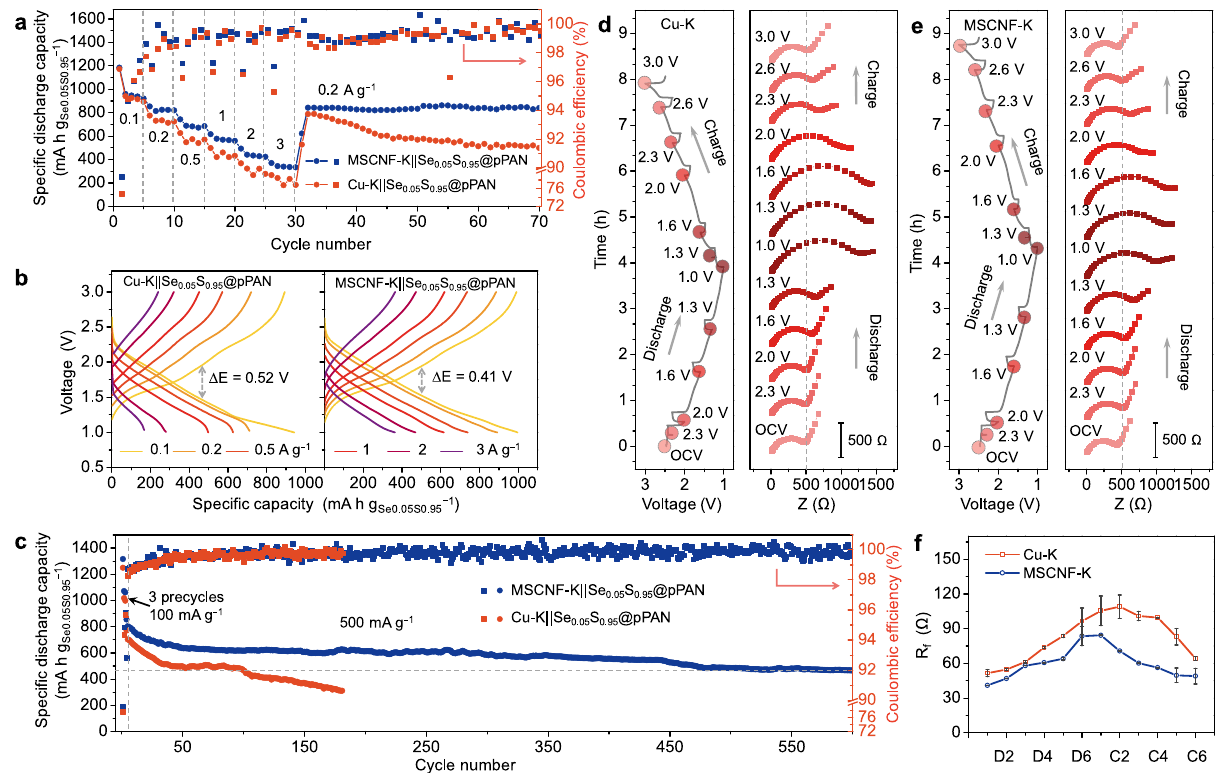
Fig. 6 | Electrochemical energy storage performance ofpotassium-sulfur cells. a Rateperformanceof fullcells comprising Cu-K and MSCN-K negative electrodes. Voltage pro fi les of cells comprising b Cu-K and MSCNF-K negative electrodes at different current rates. c Long-term cycling performance at a speci fi c current of 500mAg Se0.05S0.95 − 1 .InsituEISresultsof d Cu-K||Se 0.05 S 0.95 @pPANand e MSCNF-